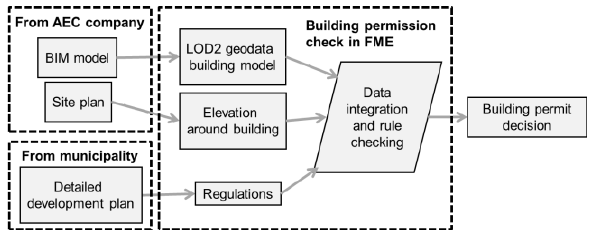
Figure 2. Workflow for data integration and building permit rule